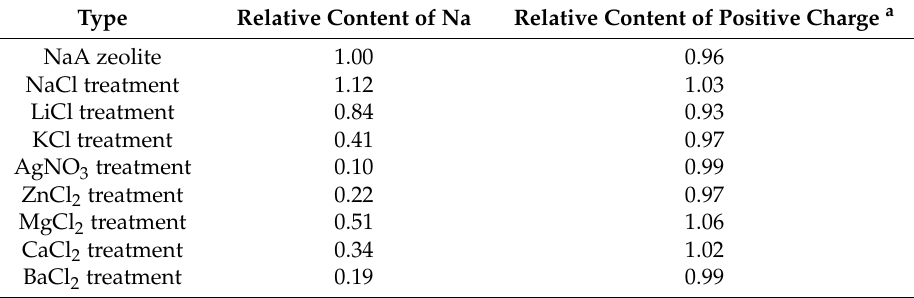
AgNO 3 treatment 0.10 0.22 0.97 MgCl 2 treatment 0.51 1.06 0.34 1.02